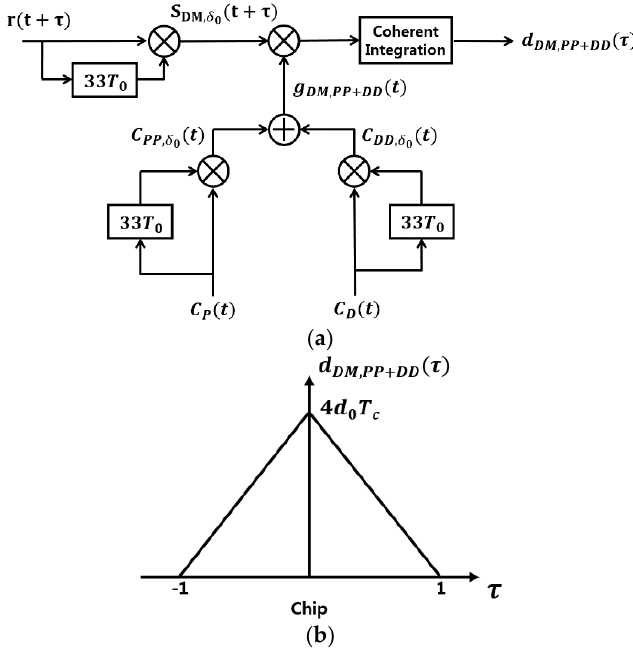
Figure 6. The proposed 33-chip delay DM acquisition scheme; ( a ) Block diagram; ( b ) The decision variable.